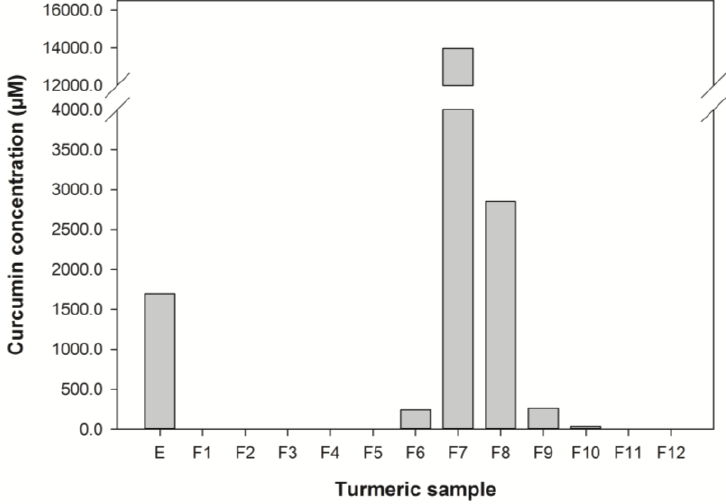
Figure 1. The concentration of curcumin in the turmeric samples used in this